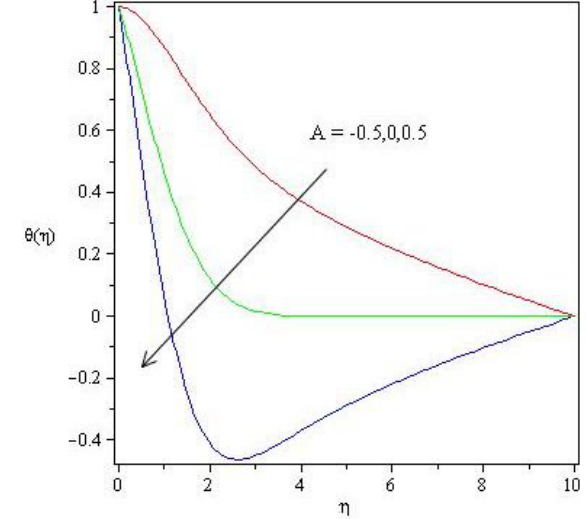
Fig. 18: Temperature profile for different values of A = −0.5, 0.5, 1